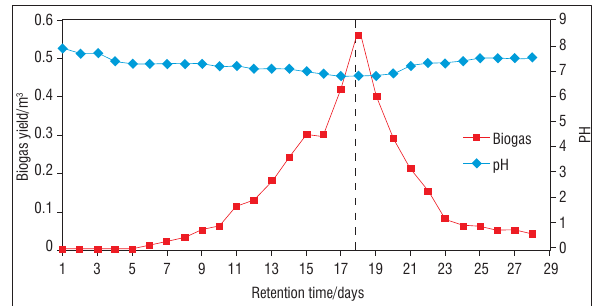
Figure 4: Biogas yield and pH values for donkey dung for a retention time